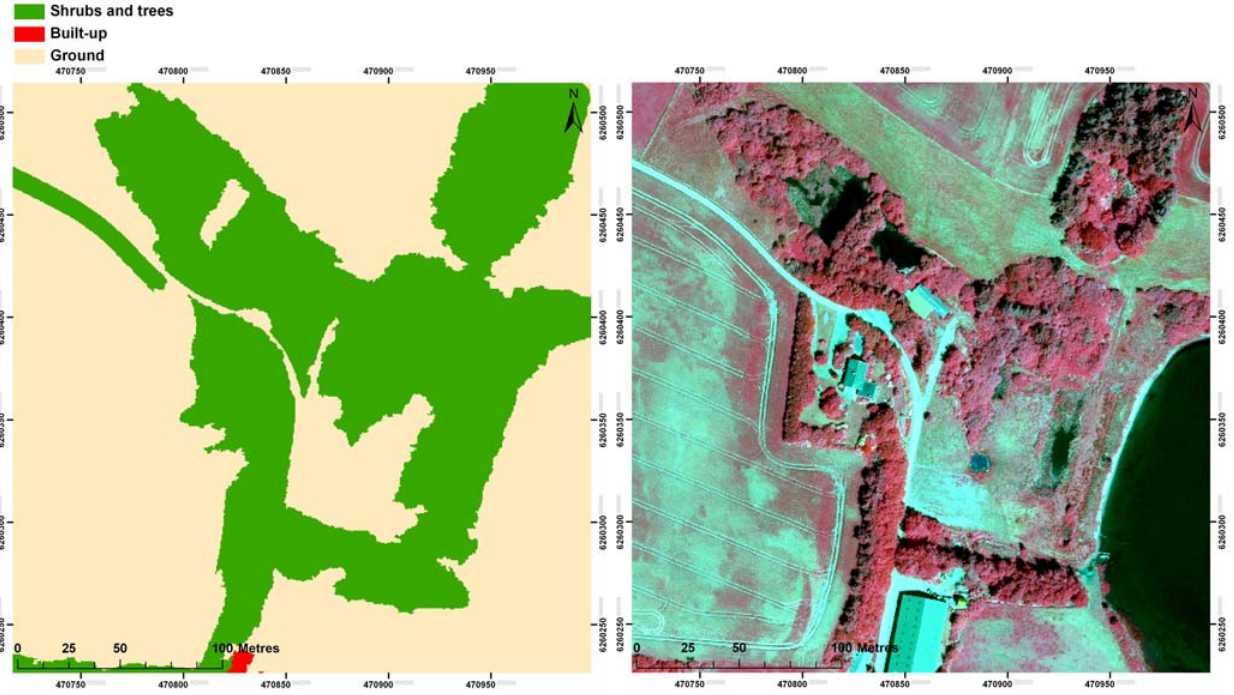
Figure 14. This example (1) shows the result of the classification based on the CIR images and the four features derived from the CART analysis. Compared to Figure 13, many ground objects have been misclassified as shrub and tree, and only one building has been correctly classified.